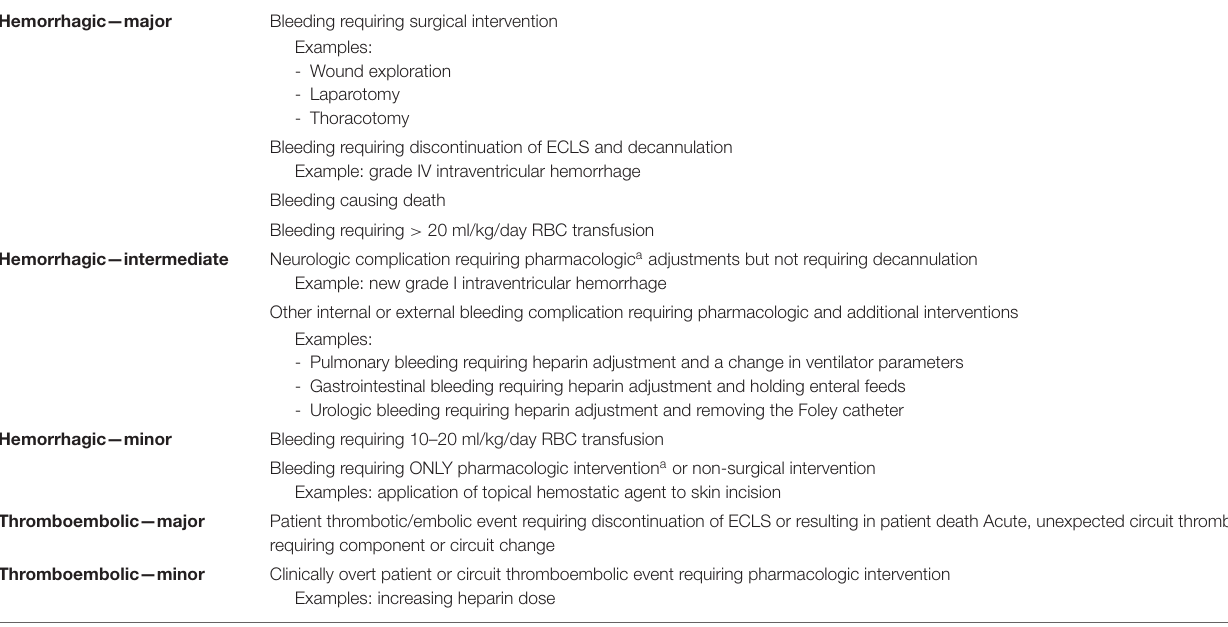
TABLE 1 | Bleeding and thrombotic complication categories and examples. Hemorrhagic—major Bleeding requiring surgical intervention Examples: - Wound